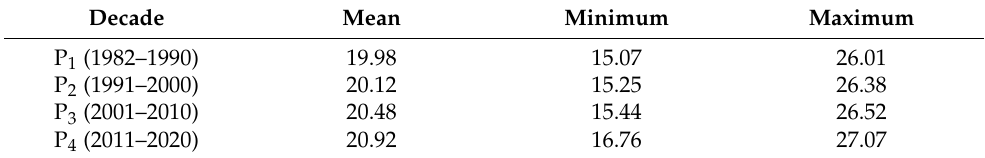
Table 1. The basin average, minimum and maximum climatological SST ◦ C during P 1 , P 2 , P 3 and P 4